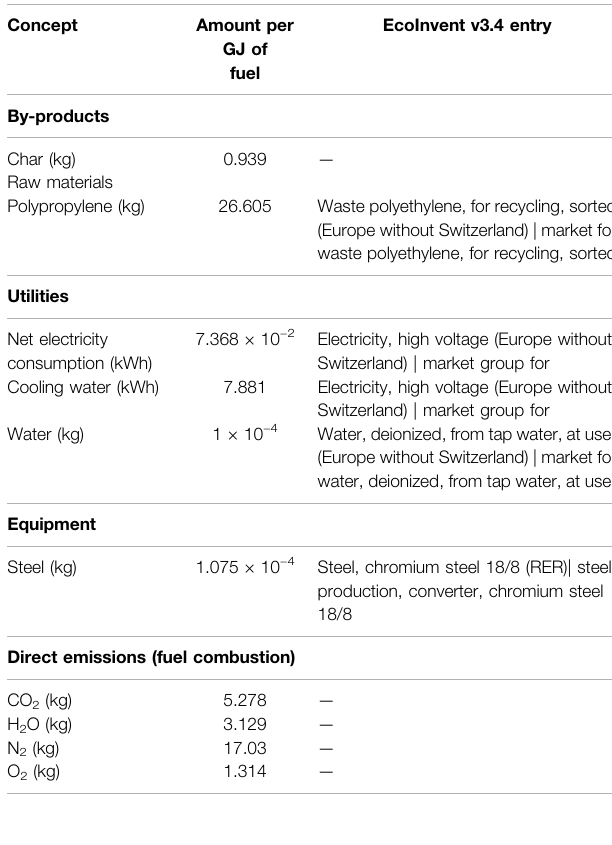
Table 5 . A cut-off approach for the PP waste inlet is